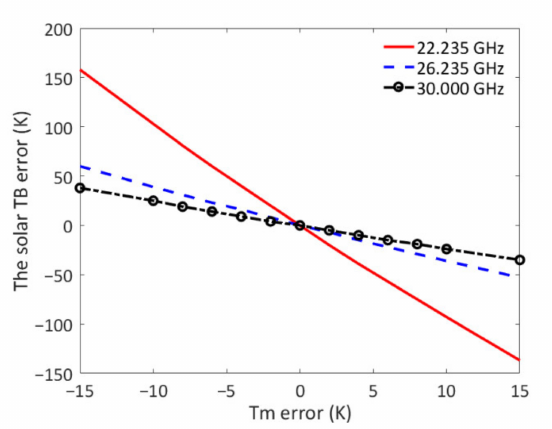
Figure 9. The mean calibration error on June 18, 2020 at the three frequencies. The calibration errors depend on the mean radiative temperature, T m . The origin represents the mean radiative temperature according to the regression method, and the error was 0.